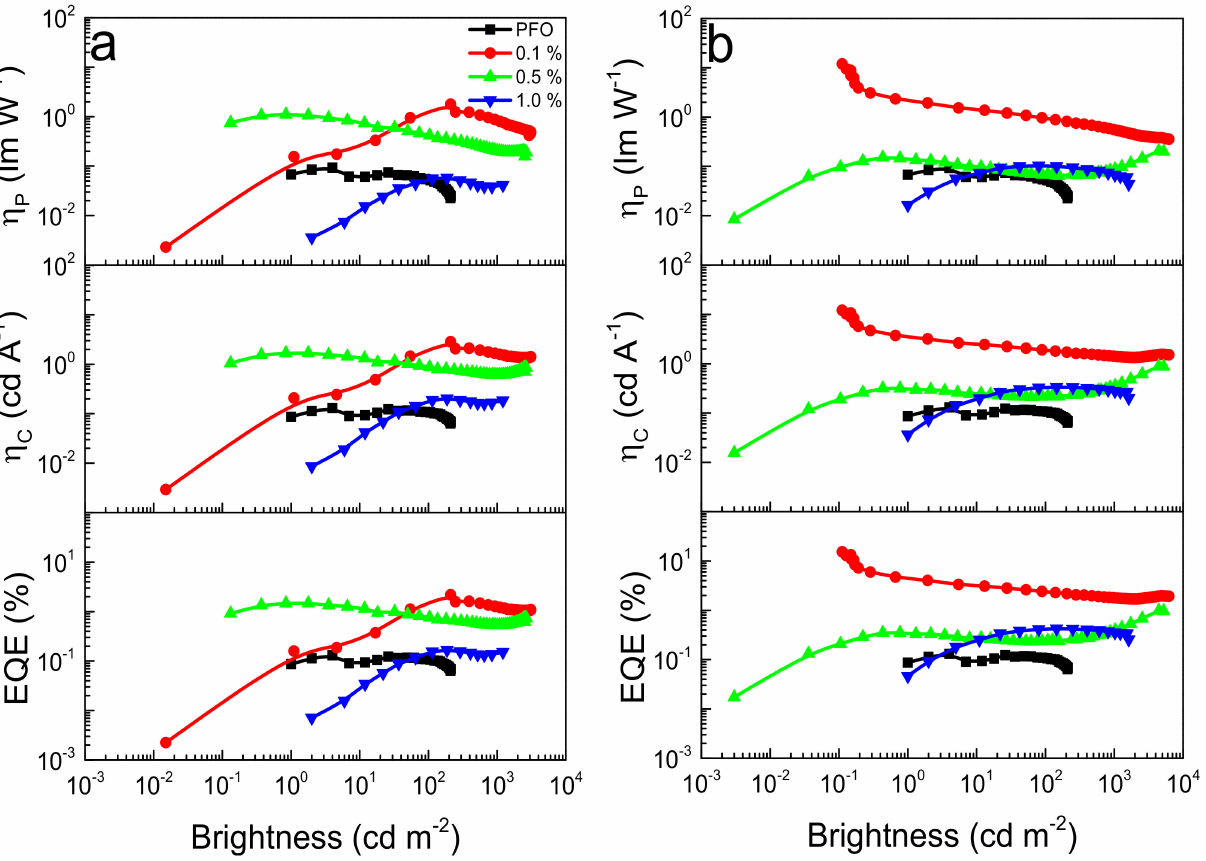
Figure 7. OLEDs figures of merit vs. brightness plots for PFO:[Pt(salophen)s] ( a ) and PFO:[Pt(sal-3,4- ben)] ( b